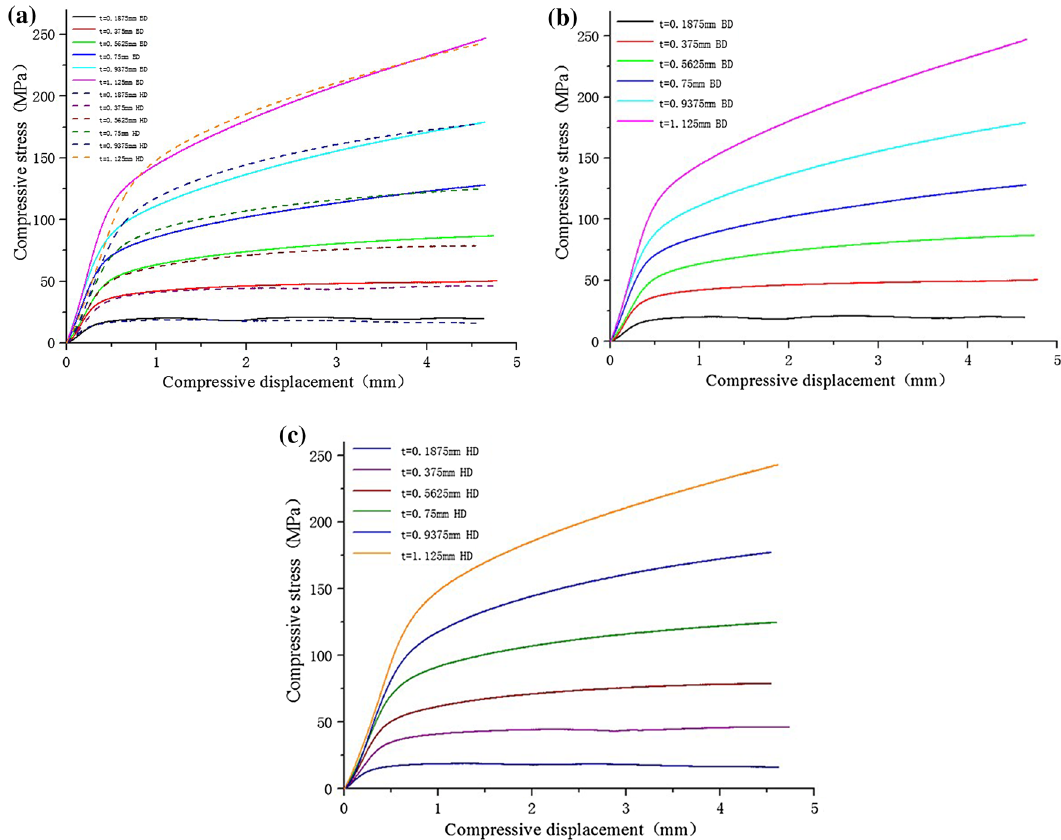
Figure 19. Compression curves of Gyroid surfaces with different wall thickness: ( a ) the compression strength curve of solid structure; ( b ) the compression strength curve of G-surface structure in BD direction; ( c ) the compression strength curve of G-surface structure in HD